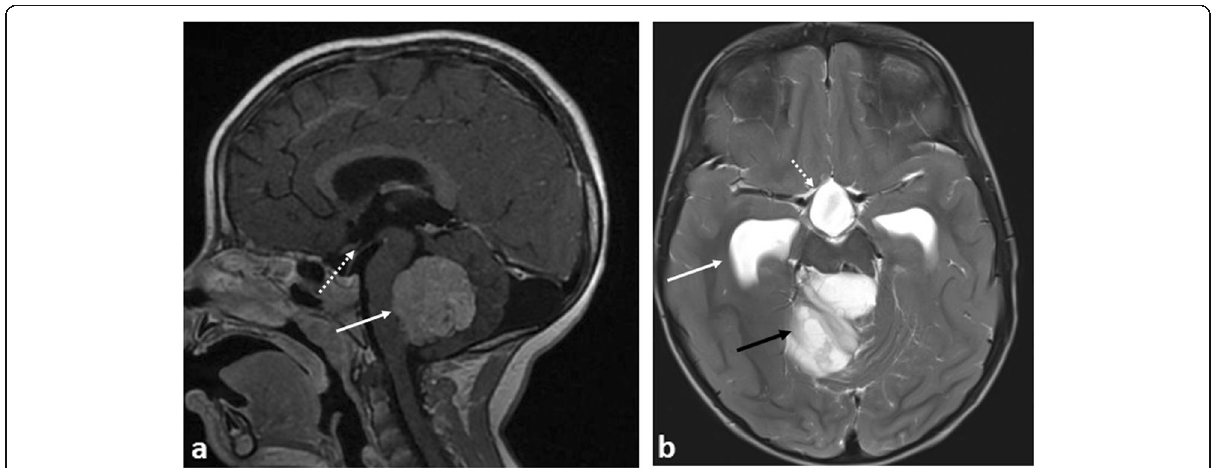
Fig. 1 Three examples of causes of obstructive hydrocephalus in different patients due to different intracranial tumours. a Sagittal post-contrast T1-weighted MRI image showing a medulloblastoma in the fourth ventricle with mass effect on the brainstem (solid white arrow). There are no early signs of hydrocephalus — the floor of the third ventricle is not bulging inferiorly (dashed white arrow) — despite the compression of the brainstem. b Axial T2-weighted MRI image in patient with a pilocytic astrocytoma in the posterior fossa (black arrow) with signs of hydrocephalus and dilatation of the temporal horns (solid white arrow) of the lateral ventricles and inferior dilatation of the third ventricle (dashed white